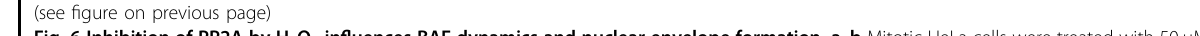
Fig. 6 Inhibition of PP2A by H 2 O 2 in fl uences BAF dynamics and nuclear envelope formation. a , b Mitotic HeLa cells were treated with 50 μ M H 2 O 2 or 100 nM okadaic acid (O.A) for 30 min. Then, the cells were immunostained for endogenous BAF (red), Lamin B1 (green) and DAPI (blue). BAF localization in telophase was classi fi ed into two categories: localization at the “ core ” region (upper, arrow), observed in control cells, and mislocalization, which means either that BAF is located in both ‘ core ’ and “ noncore ” regions (middle) or that the BAF signal is rather absent (lower). Scale bar: 10 μ m ( a ). Quanti fi cation of BAF localization. The results are shown as the means ± SDs of three independent experiments ( n = 50). *** P < 0.001 by Student ’ s t-test, compared to the control ( b ). c Time-lapse imaging of GFP-BAF. HeLa cells were transfected with a GFP-BAF expression vector and seeded in 4-well plates. Cells were synchronized at the G2 phase by using RO3306, a Cdk1 inhibitor, and then released from arrest and stained with Hoechst 33342 to visualize chromosomes during the time-lapse analysis. After 30 min, cells were treated with 50 μ M H 2 O 2 or 100 nM okadaic acid and observed at 3-min intervals. Left panel; time-lapse images, with time 0 indicating anaphase onset. Right panel; Magni fi ed images of the left panel. The arrow indicates BAF localization at the “ core ” region. d Quantitation GFP-BAF localization from the time-lapse analysis. The results are shown as the means ( n = 15). e Quantitation of the localization time of GFP-BAF at the core region from the time-lapse analysis. The results are shown as the means ± SDs ( n = 8). f HeLa cells were transfected with mock (Flag) or Flag-PP2A expression vectors, and mitotic cells were then treated with 50 μ M H 2 O 2 (H) or 100 nM okadaic acid (O.A). BAF localization was analyzed in telophase cells. C; control. The results are shown as the means ± SDs of three independent experiments ( n = 50). * P < 0.05; ** P < 0.01 by Student ’ s t -test. g and h HeLa cells were separately transfected with Flag-PP2A or Flag-PP4 expression vectors, and mitotic cells were then treated with 50 μ M H 2 O 2 . Mitotic cell lysates were harvested and subjected to western blot analysis with an anti-Flag antibody (for PP2A or PP4 expression). β -Actin; loading control ( g ). 10 h after H 2 O 2 treatment, the percentage of cells with abnormal nuclei according to Flag-PP2A or Flag-PP4 expression was determined. The results are shown as the means ± SDs of three independent experiments ( n = 100). * P < 0.05; ** P < 0.01; *** P < 0.001 by Student ’ s t -test ( h )